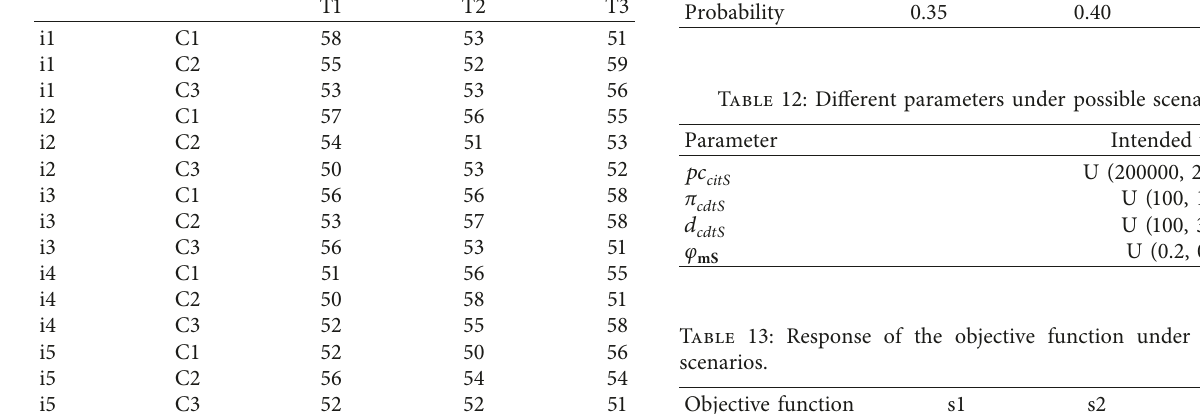
Table 6: Cost of supply of relief goods after the disaster. T1